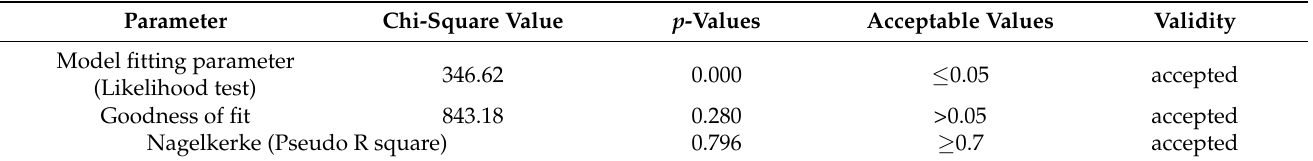
Table 6. Ordinal regression model validation parameters.